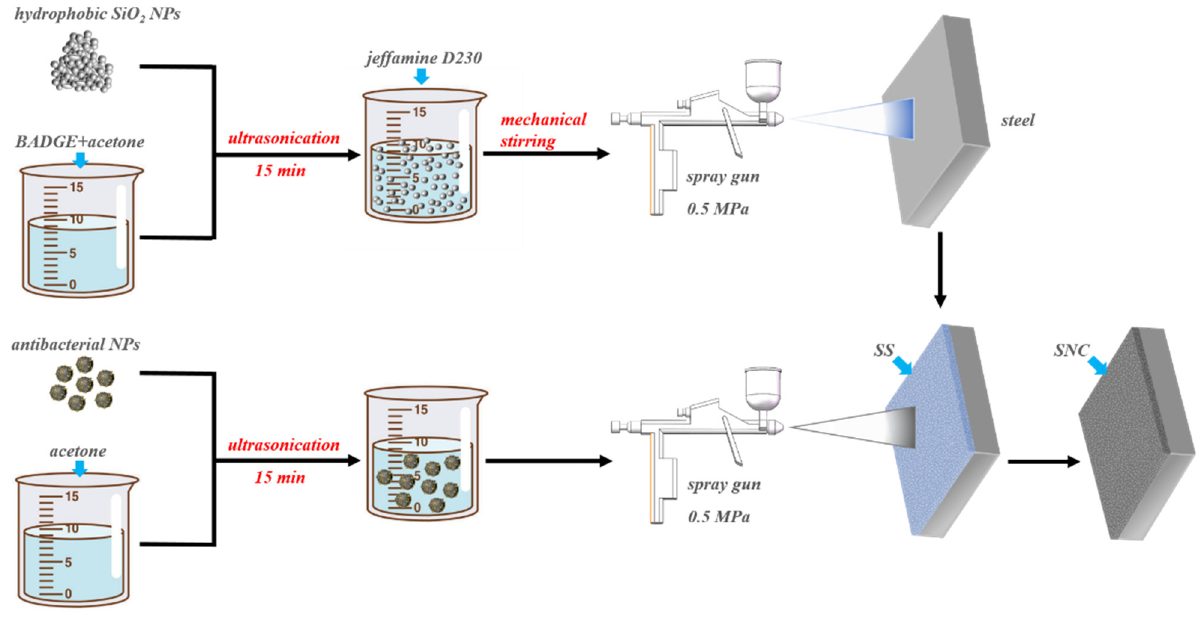
Figure 2. Schematic illustration of the preparation procedure of superhydrophobic nanocomposite coating.